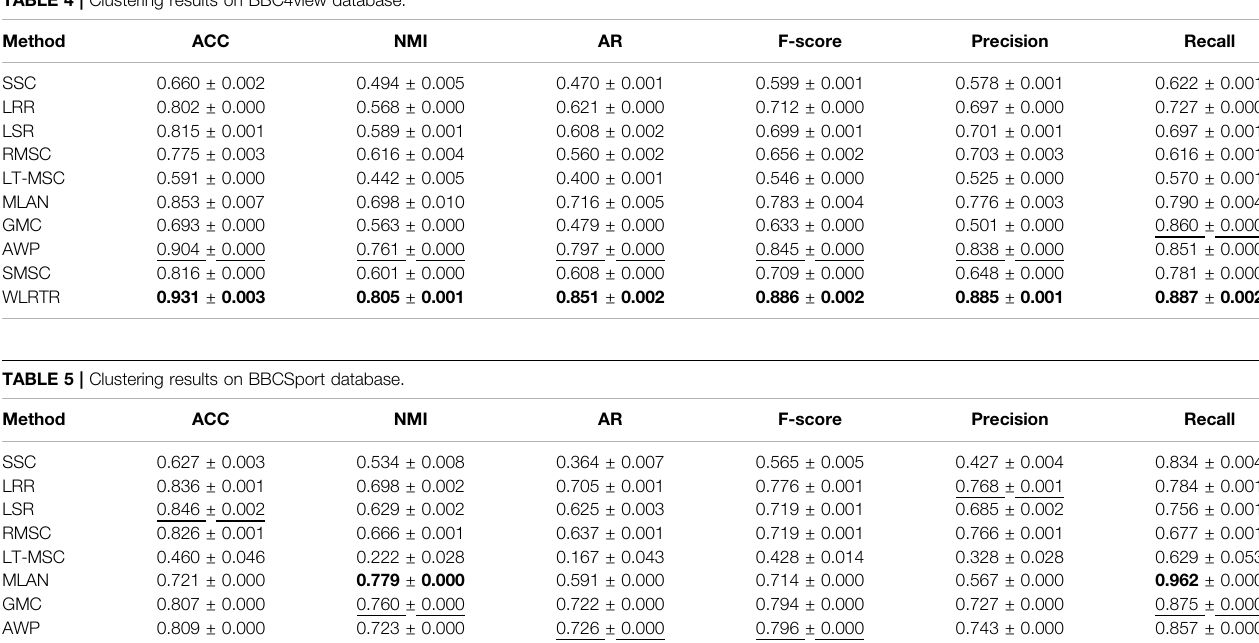
TABLE 4 | Clustering results on BBC4view database.